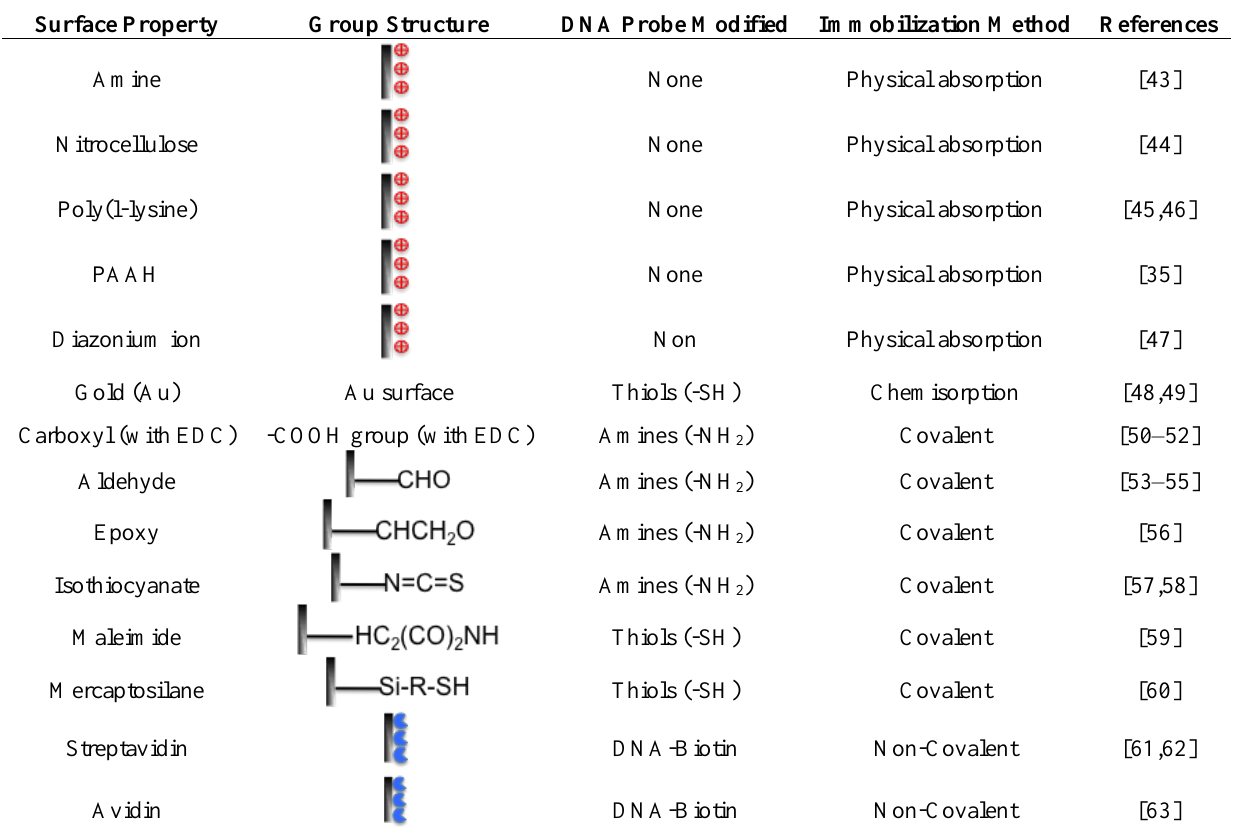
Table 2. Immobilization method of functional DNA on functionalized DNA Chip